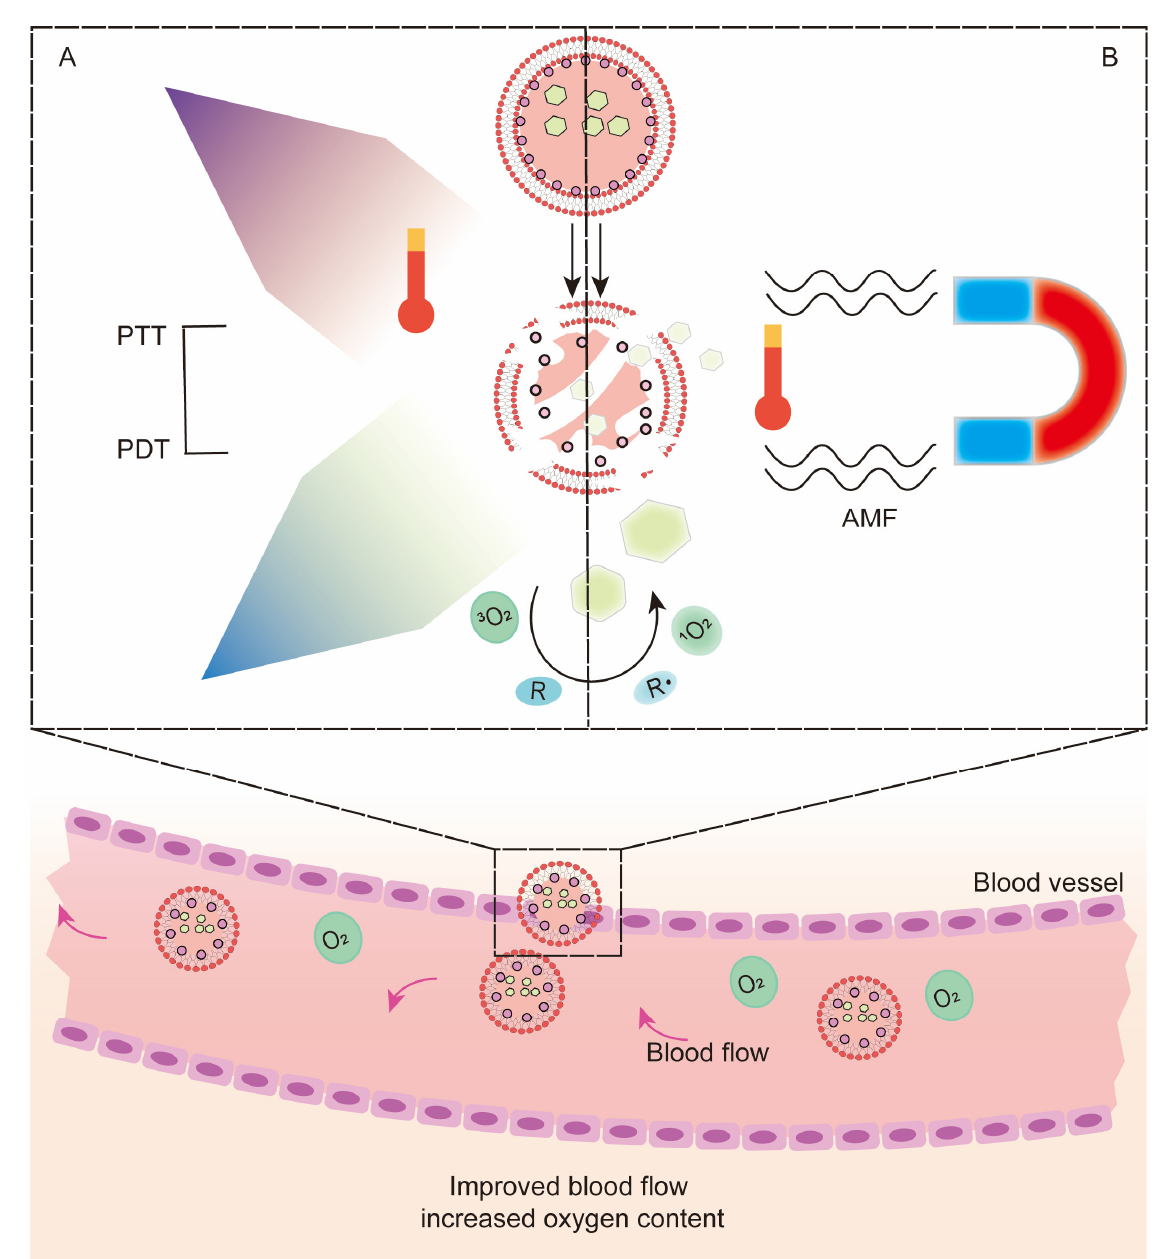
Figure 4. Mechanism of photodynamic therapy combined with photothermal therapy, hyperthermia and magnetic hyperthermia in synergistic enhancement of the antitumor effect based on codelivery systems. ( A ) When light-activated photothermal agents, ( B ) or alternating magnetic fields are applied to magnetic nanoparticles, heat is generated at the tumor site, increasing blood flow and synergistically enhancing PDTSome photothermal agents of inorganic materials themselves can be used as nanocarriers, which makes the combination of PTT and PDT convenient. Gold nanorods have been used as carriers with photothermal conversion capability, and the joint delivery of DOX and PS ICG can simultaneously achieve chemo-PTT-PDT triple therapy [69] . Gold nanocages [147] show strong absorption in the NIR region, and their empty interior and porous walls are suitable for encapsulating PSs. Bo Tian et al. [148] coupled Ce6 on PEG-functionalized